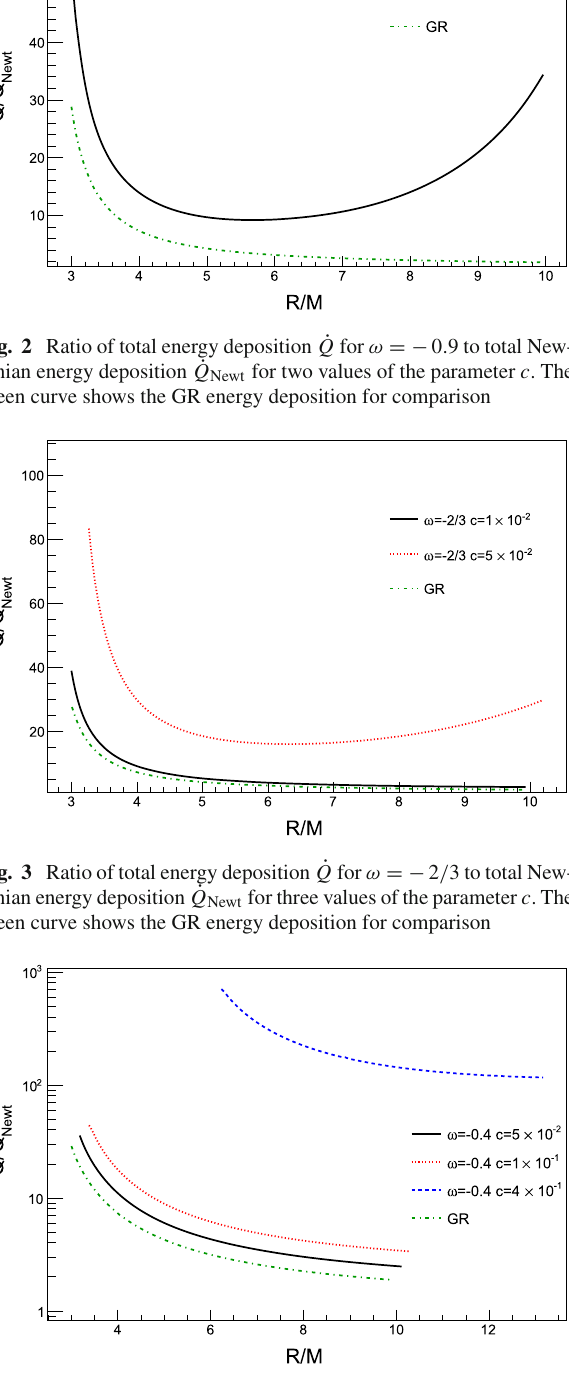
Fig. 4 Ratio of total energy deposition ˙ Q for ω = − 0 . 4 to total New- tonian energy deposition ˙ Q Newt for three values of the parameter c . The green curve shows the GR energy deposition for